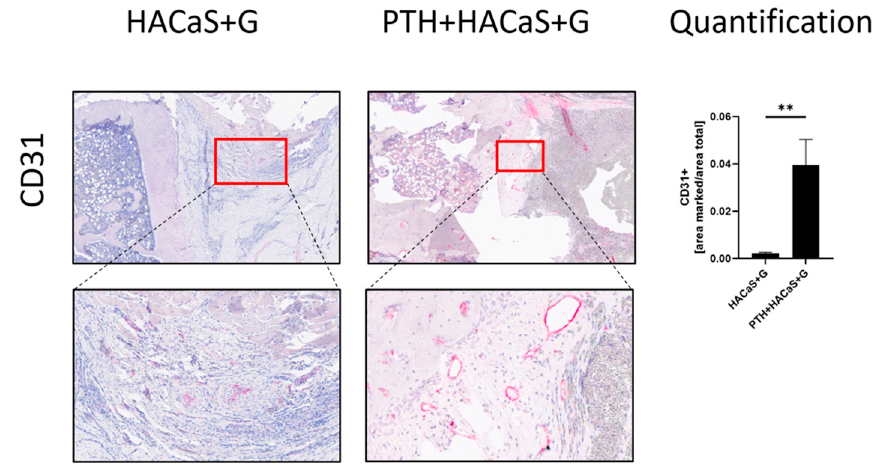
Figure 8. CD31 staining, a marker for vascularization. This is a comparison of representative parts of the defect gap between the HACaS+G- and PTH+HACaS+G-treated group. PTH leads to increased CD31 positivity in HACaS+G. ** = p < 0.01.